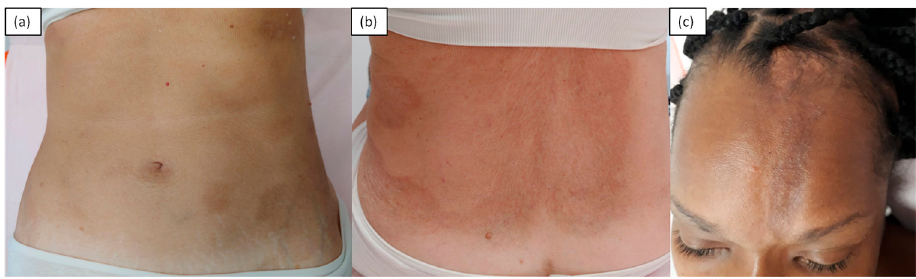
Figure 1. A 56-year-old female patient with localized scleroderma of the trunk. Slightly atrophic